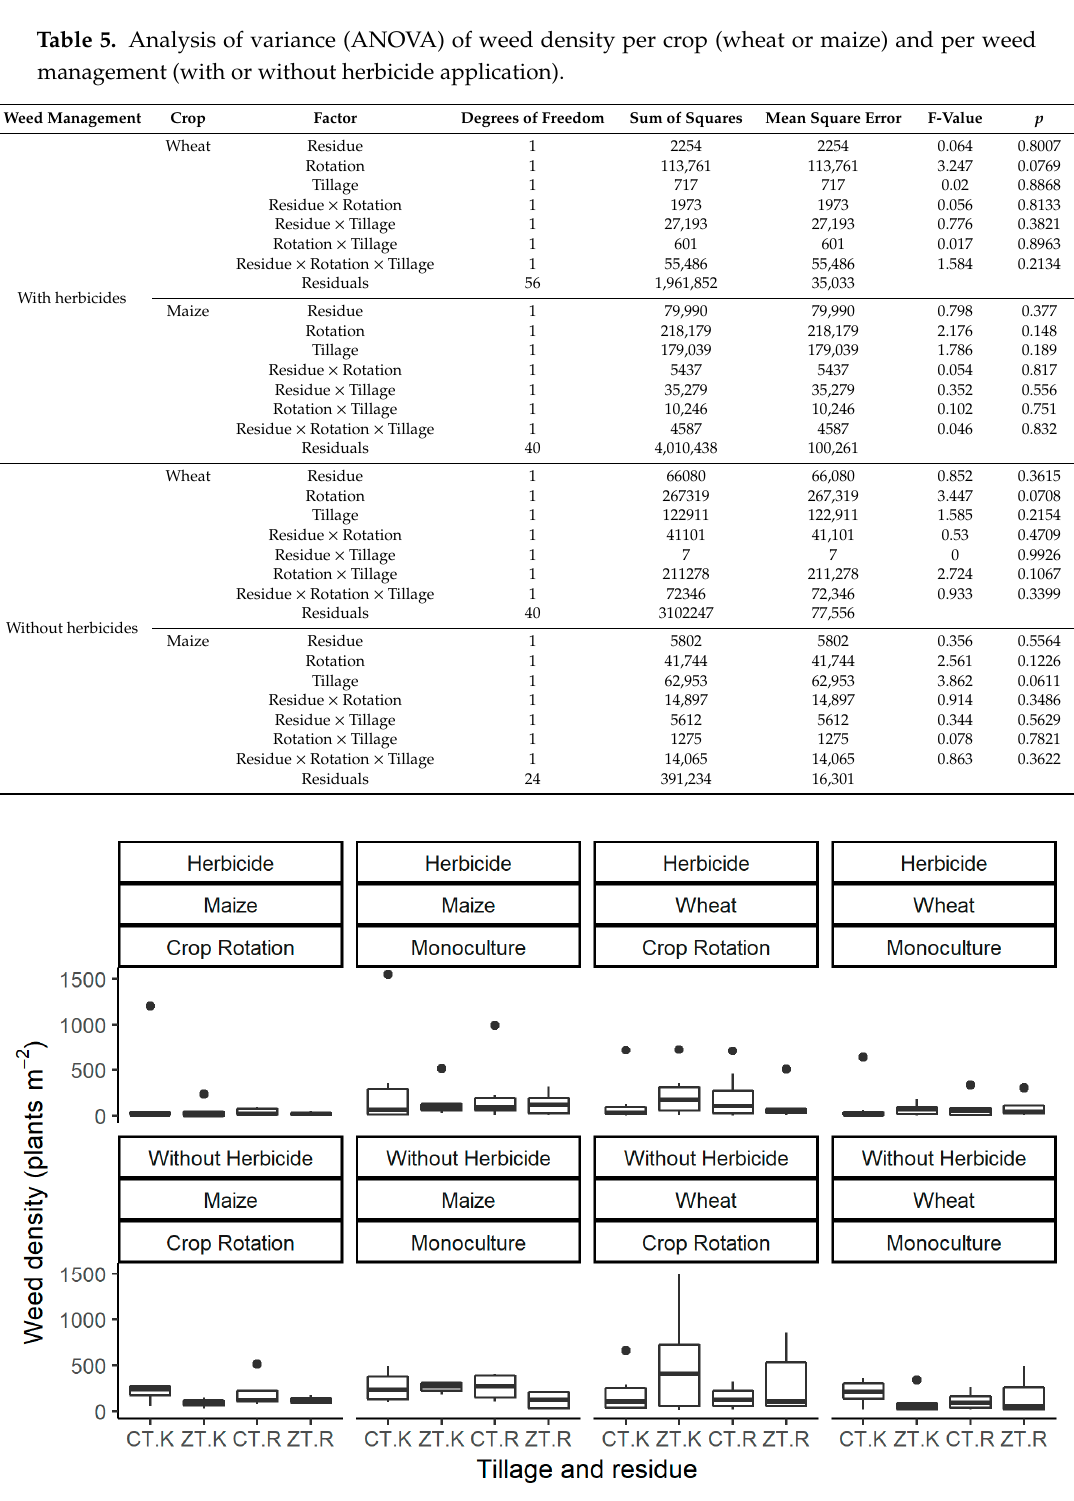
Figure 2. Boxplots of weed density with herbicide application observed in 2004, 2013, 2014 and 2015 and without herbicide application in 2013, 2014 and 2015 in terms of crop, crop rotation, tillage and residue management. CT: Conventional tillage; ZT: Zero tillage; R: Remove all residues; K: Keep all residues. n = 6 (maize) and 8 (wheat).